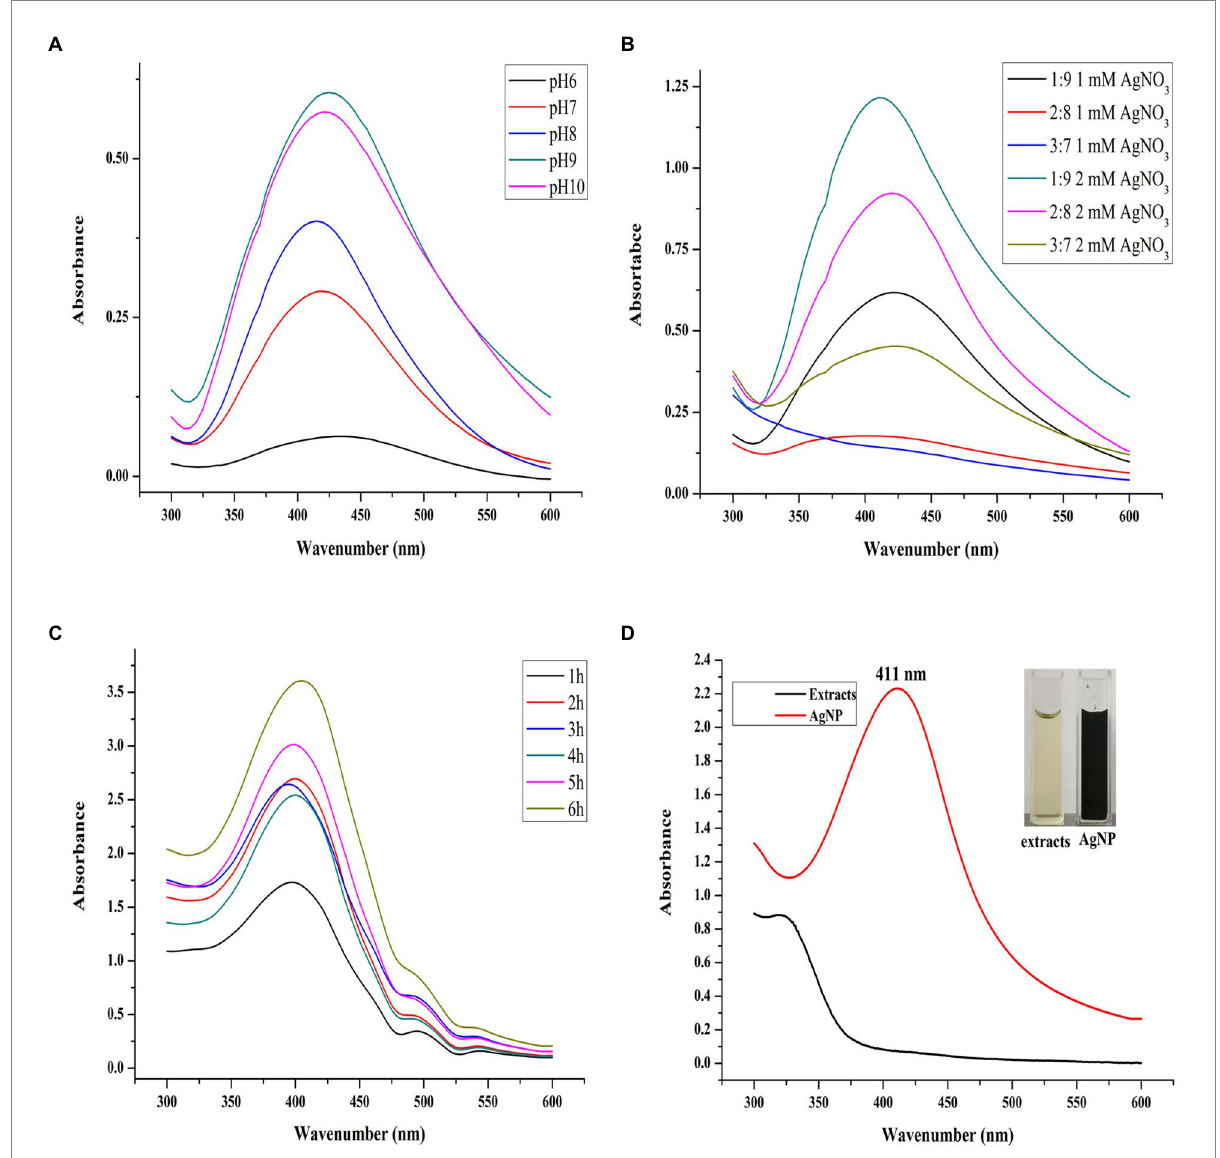
FIGURE 1 pH value, synthesis ratio, and synthesis time on AgNP synthesis. The panels (A–C) refer to the Uv–Vis scanning spectra of AgNPs synthesized at different pH values, extract to AgNO 3 ratios, and reaction times, respectively. The panel (D) refers to the synthesis of AgNPs at the optimal parameters and their color